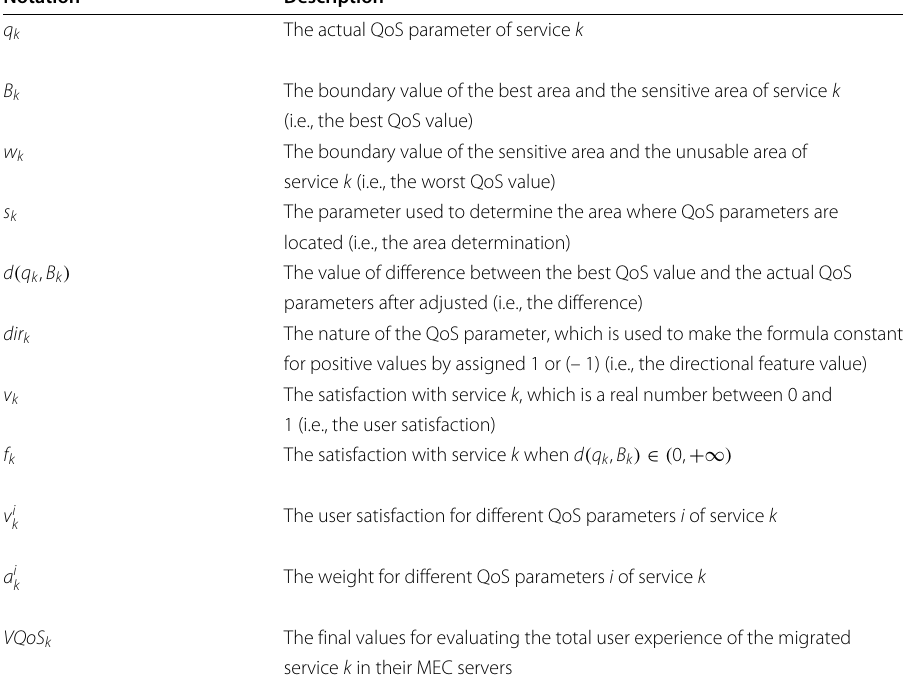
Table 1 The notations of